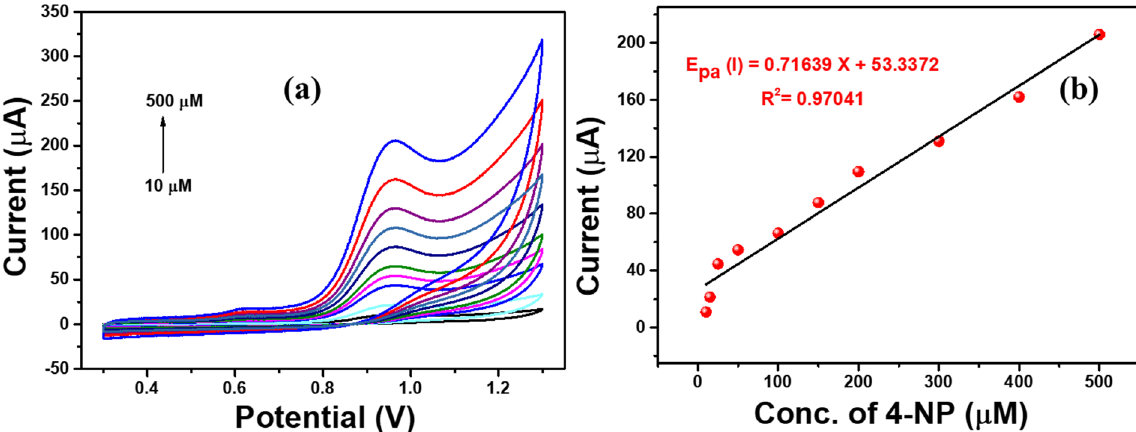
Figure 8. ( a ) CV responses of Ag-ZnO/GCE at different 4-NP concentrations (10 µM to 500 µM) containing 0.1 M PBS (pH = 7) solution at a scan rate of 100 mVs − 1 . ( b ) Linear regression plot of current vs. 4-NP concentration. (Accumulation time: 2 min, catalyst loading volume: 10 µL).